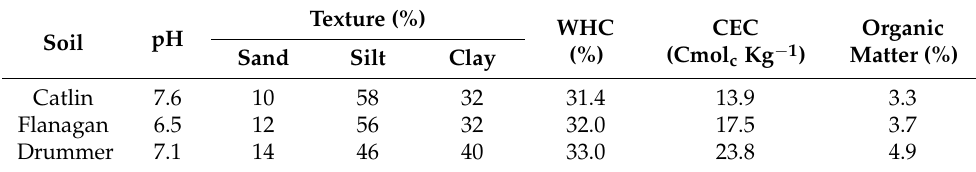
Table 1. Selected properties of the soils used in the